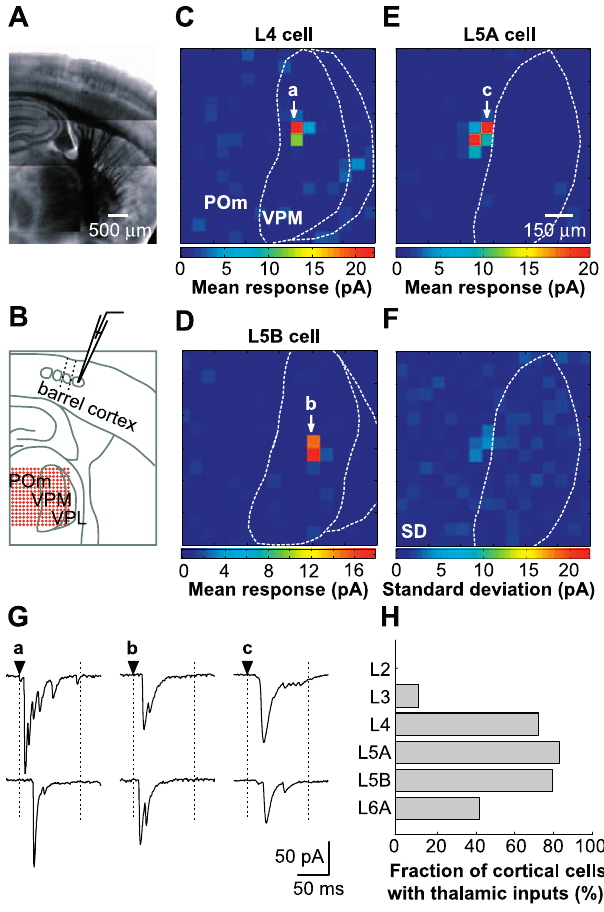
Figure 1. Laser Scanning Photostimulation Mapping of Thalamocortical Projections (A) Montage of a thalamocortical slice. (B) Layout of the experiment. Excitatory neurons were recorded in the barrel cortex while thalamic neurons were photostimulated by glutamate uncaging. The map pattern (red grid) was centered on the POm/VPM boundary. Dashed lines indicate a barrel-column. (C–E) Examples of synaptic input maps for individual L4 (C), L5B (D), and L5A (E) neurons. The pixel values encode the mean amplitudes of EPSCs measured within 100 ms after the stimulus (see [G]). The dashed lines indicate the borders between POm, VPM, and the ventral posterolateral nucleus (VPL) (see [B]). Letters mark a pair of pixels corresponding to the traces shown in (G). (F) Map of standard deviations across trials for an individual cell (same cell as in [E]). (G) Examples of individual EPSCs. The responses were evoked by photostimulation at the sites indicated by letters in (C–E) (two sites per arrow). Arrowheads indicate the timing of the stimulus; dashed lines indicate the averaging window used for analysis. (H) Percentage of cortical cells with thalamic input. The percentage was computed for cells that were within a lateral distance of 300 l m of cells that showed thalamic input in the brain slice. DOI: